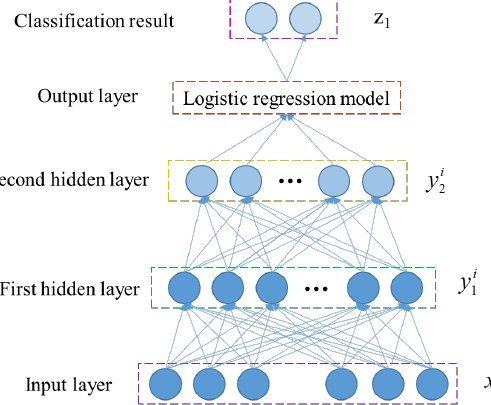
Figure 15. The relationship between batch size and accuracy rate.